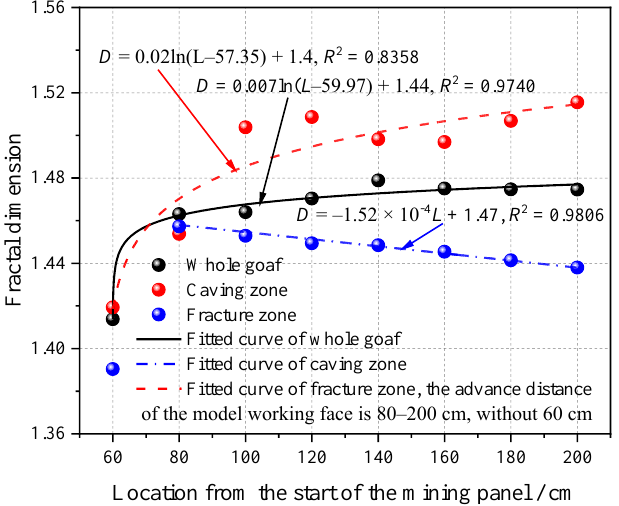
Figure 9. Relation between the fractal dimension and advancing distance of the working face.